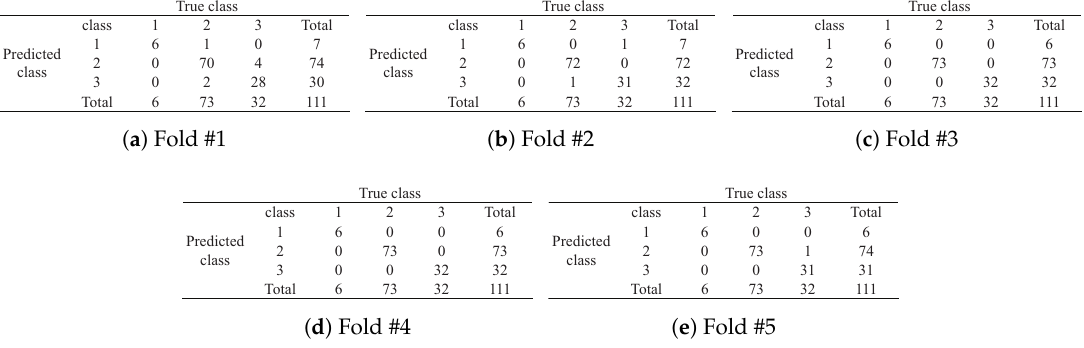
Figure 6. Confusion matrices for the proposed ensemble model for different cross-validation folds.